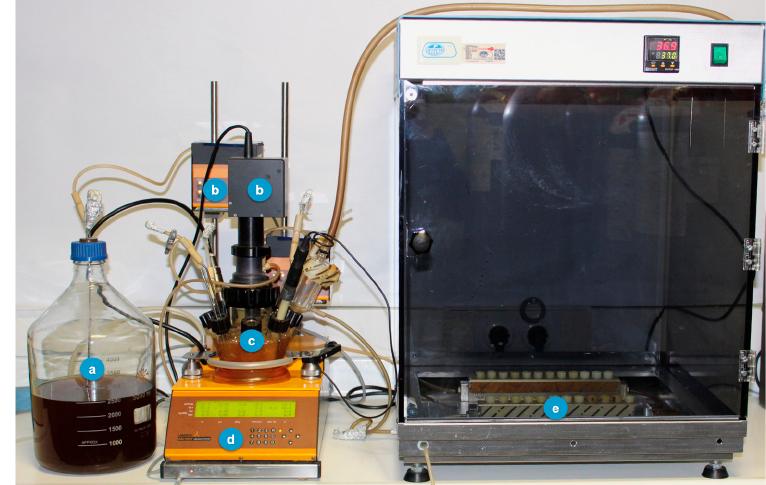
Figure 7. Modified model to generate biofilm over implants with the Robbins devices in series. ( a ) Culture medium – modified BHI; ( b ) Peristaltic pumps; ( c ) Incubation recipient; ( d ) Bioreactor (tem ‐